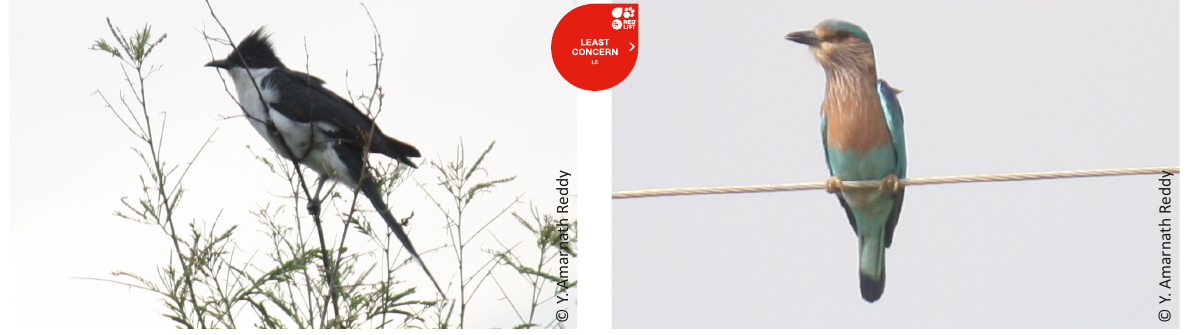
Image 8. Coracias benghalensis Indian